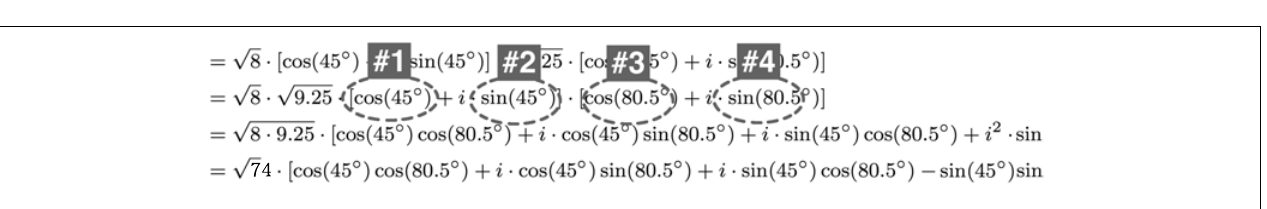
FIGURE 5 | Snippet of Leo’s example sheet. Leo points at these four positions while she seems to read out parts of the line